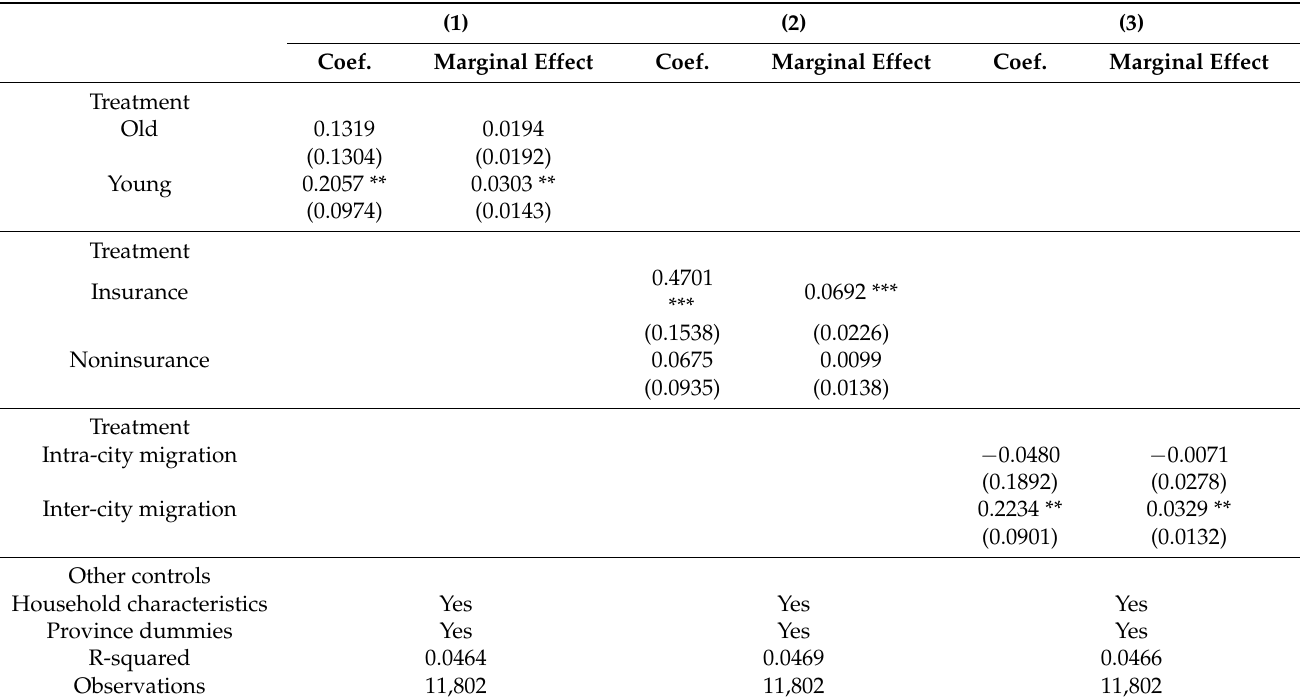
Table 7. Further analyses: heterogeneity results among